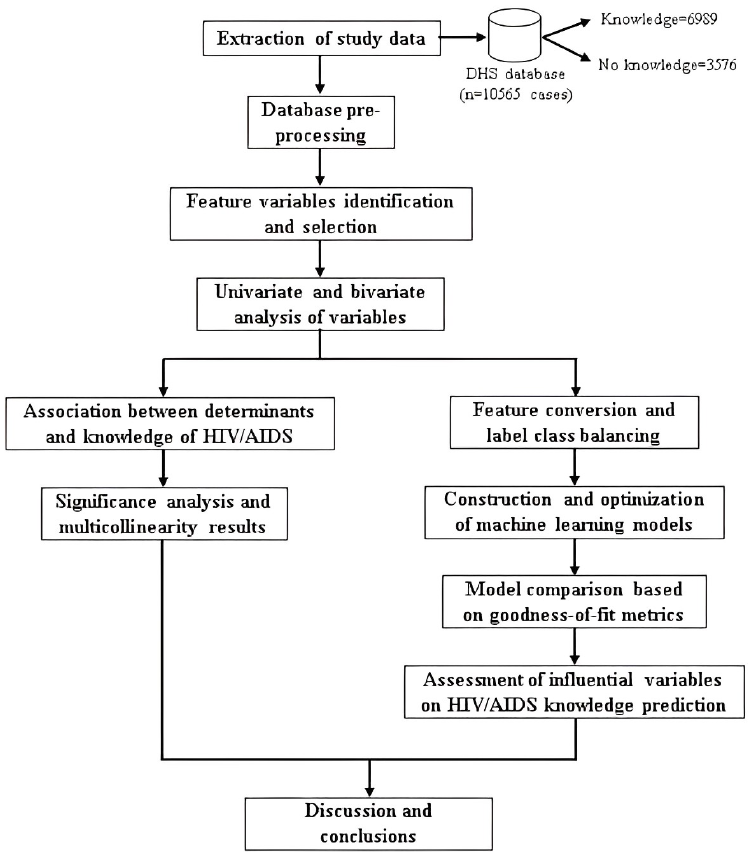
Figure 1. Study methodology diagram for the study of HIV/AIDS knowledge among the adolescent and young adult population in